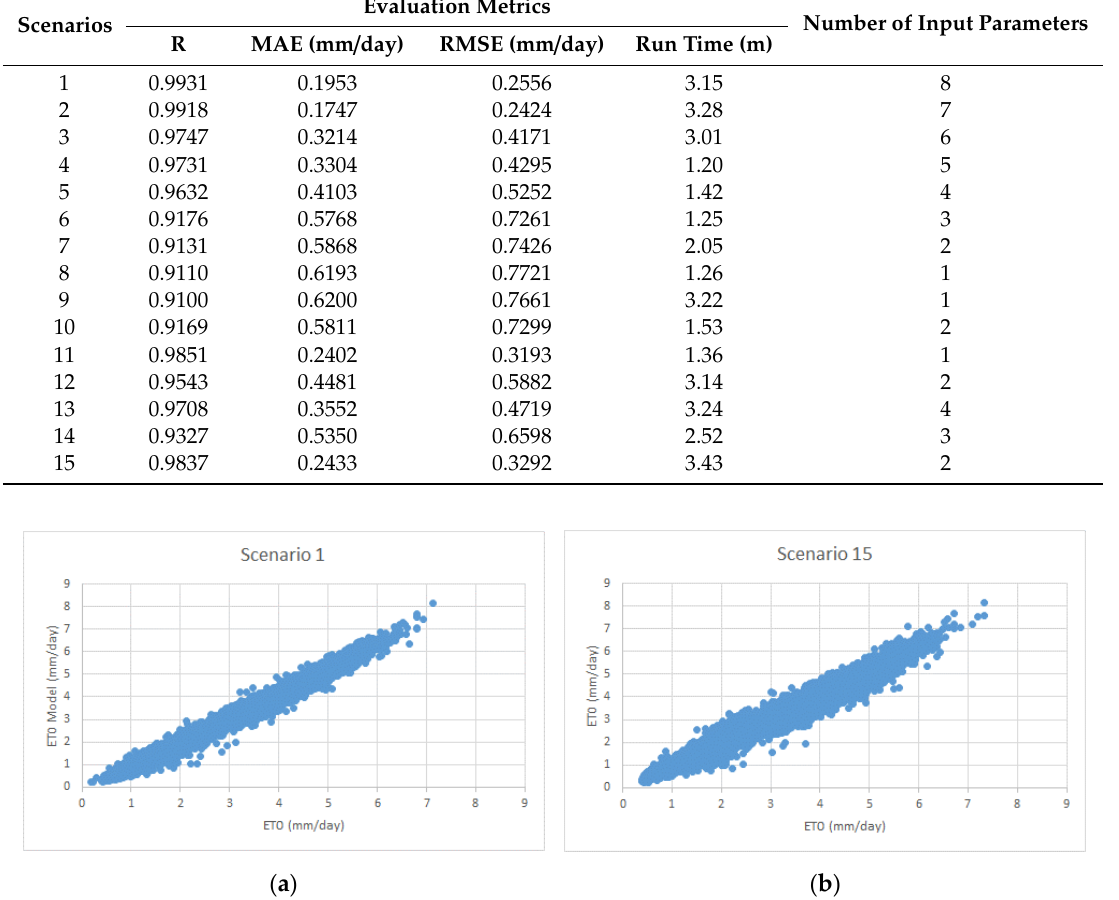
Figure 9. GRU model scatters plot for ( a ) scenario 1 and ( b ) scenario 15.